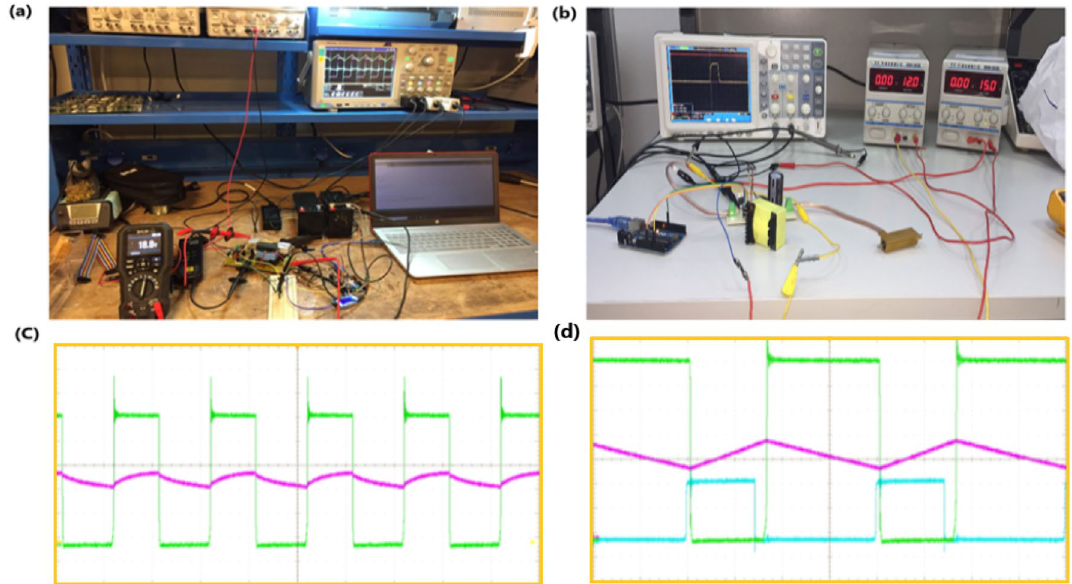
Figure 10. Hardware setup of the proposed system ( a ), the buck-boost converter and inductor design ( b ) the buck-boost converter Mosfet drain-source voltage (green) and output current (purple) ( c ) and the Mosfet drain-